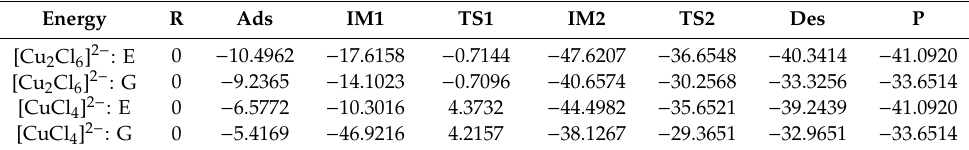
Figure 14. Step-by-step reaction process, in which the reactants C 2 H 2 and HCl are adsorbed and react near the Cu(II) active site. The red and blue lines represent the cases with the participation of [Cu 2 Cl 6 ] 2 − while the black and green lines represent the cases catalyzed by [CuCl 4 ] 2 − . Table 4. Energy levels of the reaction steps shown in Figure 14 (kcal/mol).